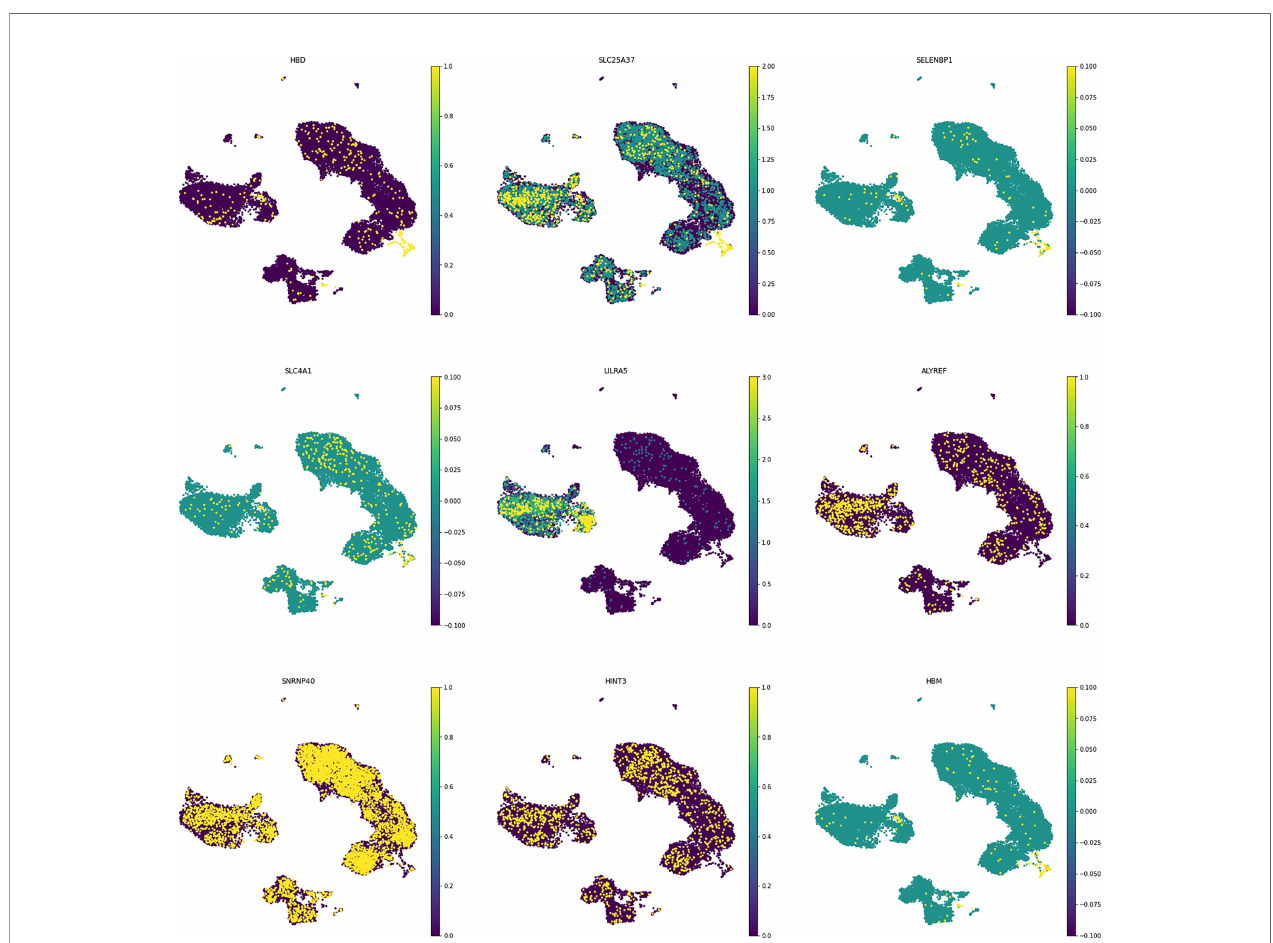
FIGURE 7 | Selected hub-genes expression in different cell populations. The shared genes showed different expression values between other immune